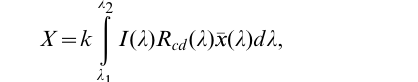
Figure S1 X-ray diffraction and IR characterization of Rı´o Celeste sediments. ( a ) Photography of a rock obtained from Rı´o Celeste bottom with deposited sediments on its surface. ( b ) X-ray diffraction pattern of white sediments showed in Fig. S1a. ( c ) Infrared spectrum and characteristic IR vibrational bands of the white solid power.